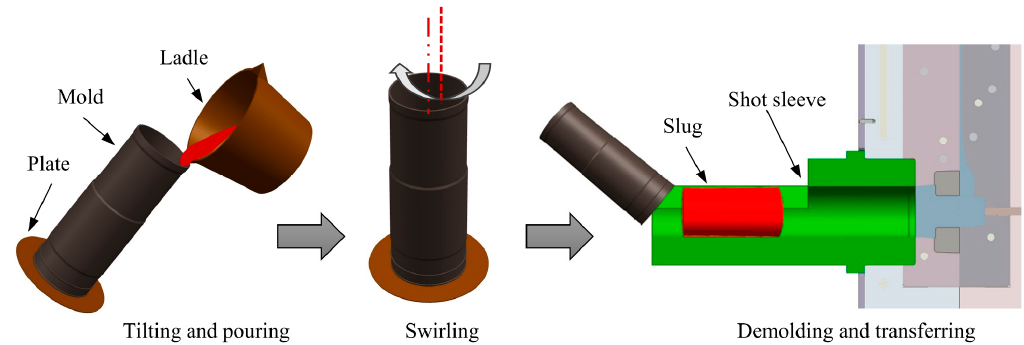
Figure 1. Schematic of the Swirled Enthalpy Equilibration Device (SEED) process. Adapted from Côté et al. [2].